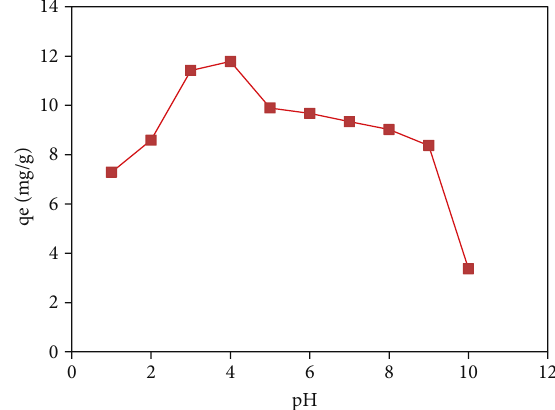
Figure 7: E ff ect of pH for the adsorption of MB ions onto Neolamarckia cadamba